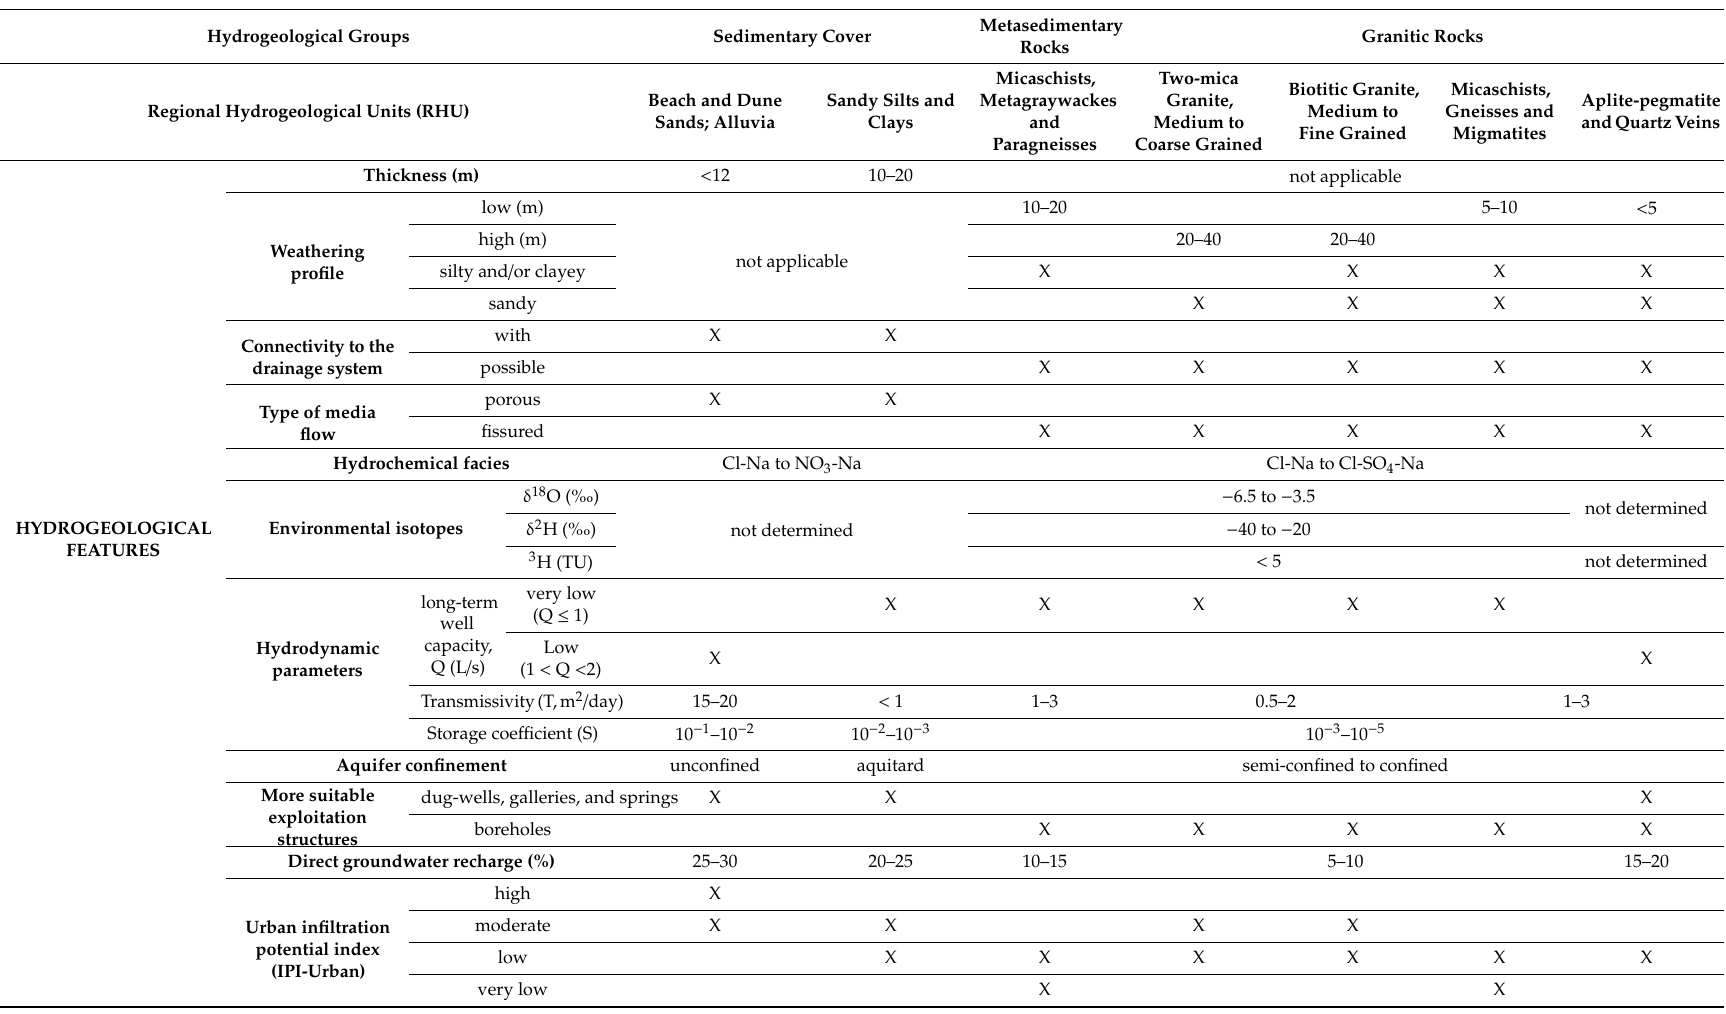
Table 1. Regional hydrogeological units (cf. Figure 2) and related features in the Porto urban region (summarized and updated from